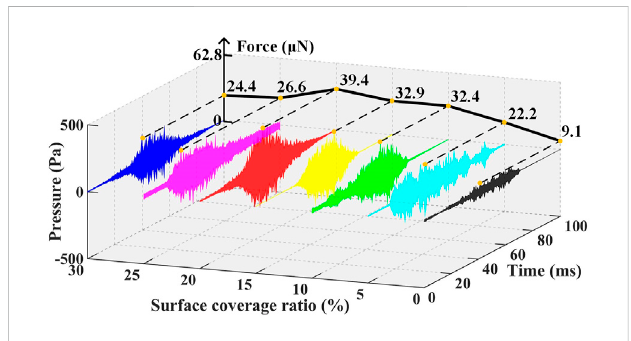
The shockwave-like fl ow pressures and corresponding forces of different surface coverage ratios as a function of